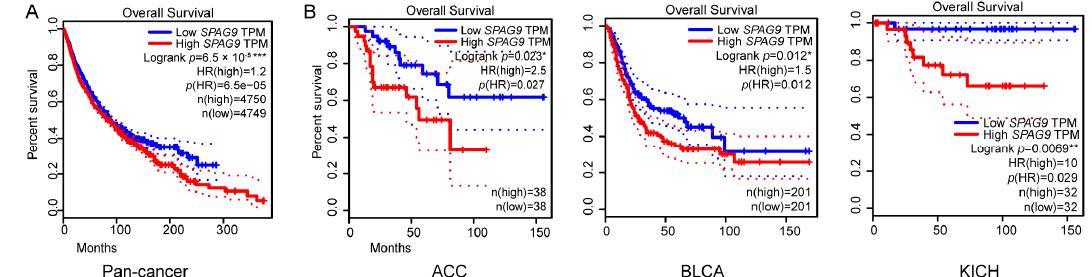
Figure 2. Survival analysis of SPAG9 in pan-cancer. ( A ) Using GEPIA2 online tool, Kaplan–Meier survival analysis of 31 kinds of tumor patient, counting up to 9549, was performed. Median SPAG9 TPM was chosen as the group cutoff. The 95% CI is shown by the dotted lines. ( B ) Using GEPIA2 online tool, Kaplan–Meier survival analysis was performed on all tumor types except for ccRCC. Only significant results are shown. Abbreviations: ACC, adrenocortical carcinoma; BLCA, bladder urothelial carcinoma; KICH, kidney chromophobe. * p value < 0.05, ** p value < 0.01, *** p value < 0.001.